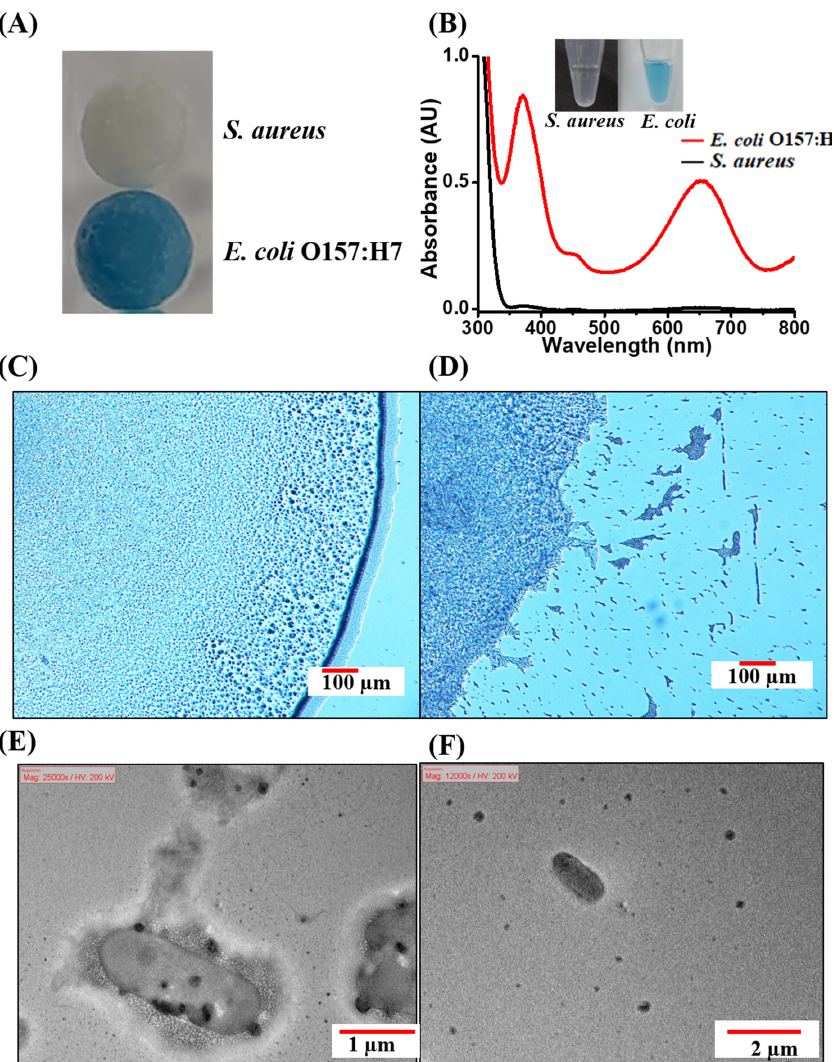
Figure 1. ( A ) Photographs of the cotton swabs obtained after sampling the bacterial samples (50 µL) containing E. coli O157: H7 (OD 600 = ~1) and S. aureus (OD 600 = ~1), after reacting with the reagent (50 µL) containing TMB (1.25 mM) and H 2 O 2 (11.2 mM) at pH 3 for 25 min. ( B ) UV-Vis absorption spectra of the bacterial samples (0.2 mL) including E. coli O157: H7 (OD 600 = 1) and S. aureus (OD 600 = 1) obtained after reaction with TMB and hydrogen peroxide (11.2 mM) at pH 3 for 25 min, followed by the reaction with additional hydrogen peroxide (7.2 M, 5 µL) for another 5 min. The inset shows the photographs of the resultant samples. Representative microscopic images of E. coli O157: H7 ( C ) without and ( D ) with the addition of H 2 O 2 (11.2 mM, 2 µL) at pH 3. The bacterial samples were stained with methylene blue (1 mM, 2 µL) for 2 min before investigation by the optical microscope. ( E , F ) Corresponding TEM images of the samples shown in panels ( C , D ).